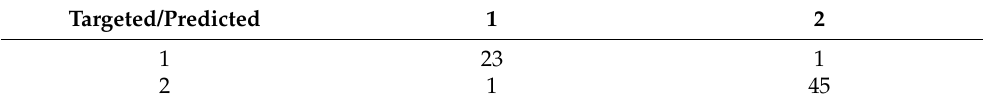
Table 12. The confusion matrix for our proposed ConvLSTM architecture on the AIRTLab dataset. Targeted/Predicted